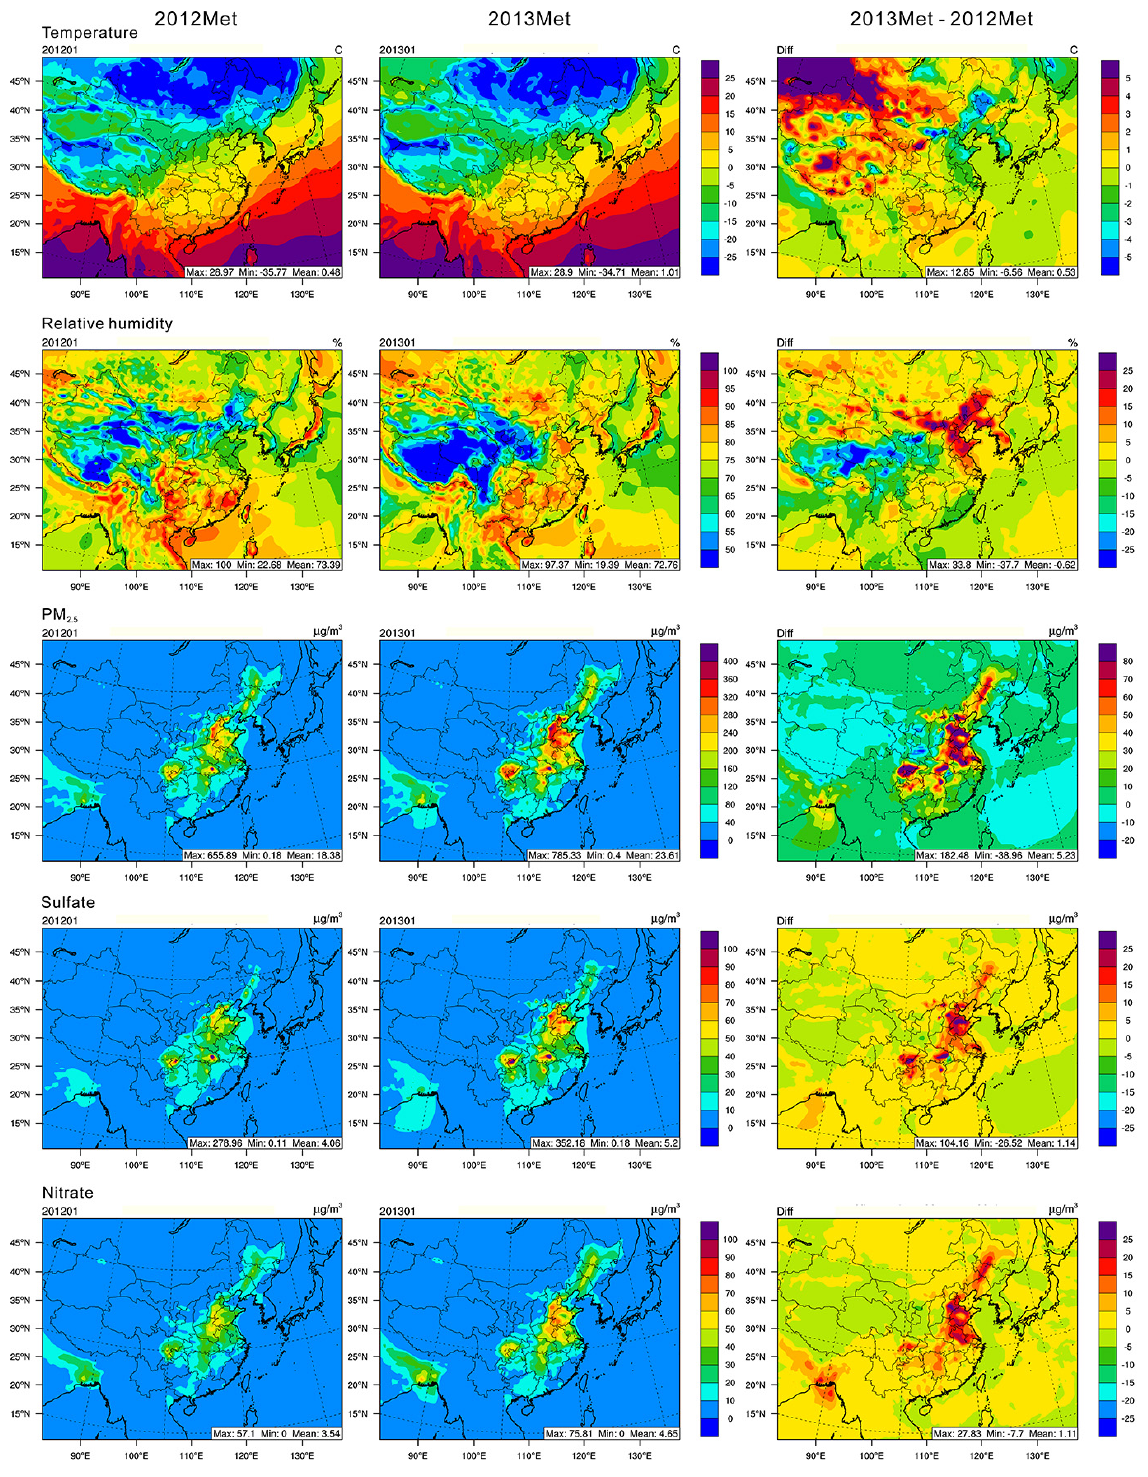
Figure 8. Spatial distributions of the monthly (January 2013) mean temperature, RH and concentrations of PM 2 . 5 , sulfate and nitrate sim- ulated by the revised CMAQ model with meteorological fields of 2012 (left) and 2013 (middle), and the differences between these two simulations